Question: Give a one-sentence summary of this figure.
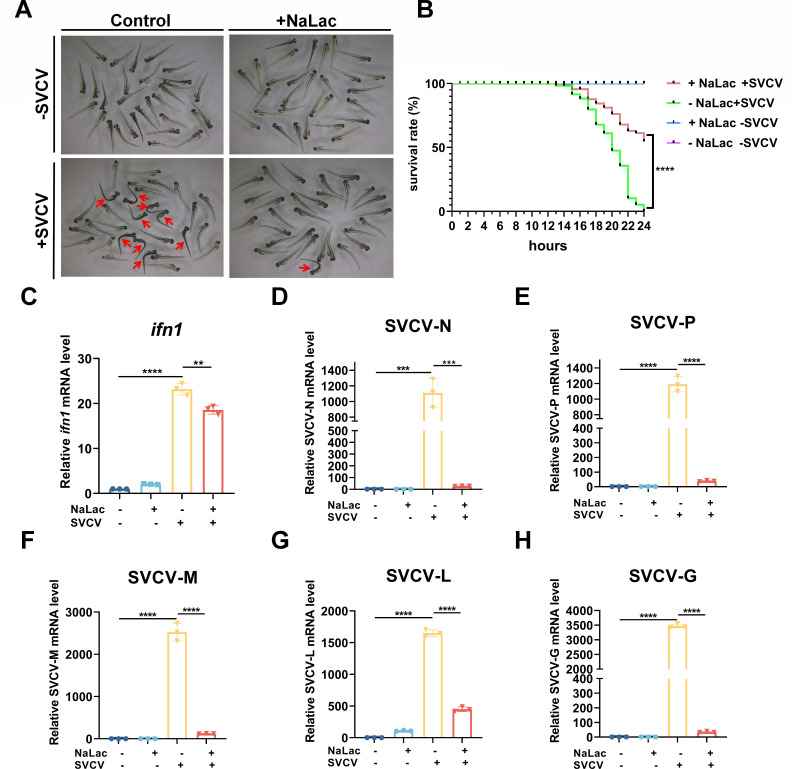
Answer: The addition of sodium lactate to living water protects against SVCV in zebrafish larvae. ( A ) Images of zebrafish larvae (4 dpf) treated with sodium lactate (5 mM) or sea salt (5 mM) control after being infected (12 h) or not infected with SVCV (~2.5 × 10 7 TCID 50 /mL). Red arrows indicate the deceased larvae, characterized by motility cessation, circulatory arrest, and body degeneration. ( B ) Survival curves for zebrafish larvae treated with sodium lactate (5 mM) ( n = 96) or sea salt (5 mM) control after infection or no infection with SVCV (~2.5 × 10 7 TCID 50 /mL), monitored hourly for up to 24 h after SVCV exposure. ( C ) qRT-PCR analysis of ifn1 mRNA in zebrafish larvae treated with sodium lactate (5 mM) or sea salt (5 mM) control after infection (12 h) with or without SVCV (~2.5 × 10 7 TCID 50 /mL). ( D–H ) qRT-PCR analysis of N ( D ), P ( E ), M ( F ), L ( G ), and G ( H ) protein mRNA in zebrafish larvae treated with sodium lactate (5 mM) or sea salt control (5 mM) control after infection (12 h) with or without SVCV (~2.5 × 10 7 TCID 50 /mL). The data presented are the means ± SEM, based on one representative experiment performed in triplicate. * P < 0.05; ** P < 0.01; *** P < 0.001; **** P < 0.0001.